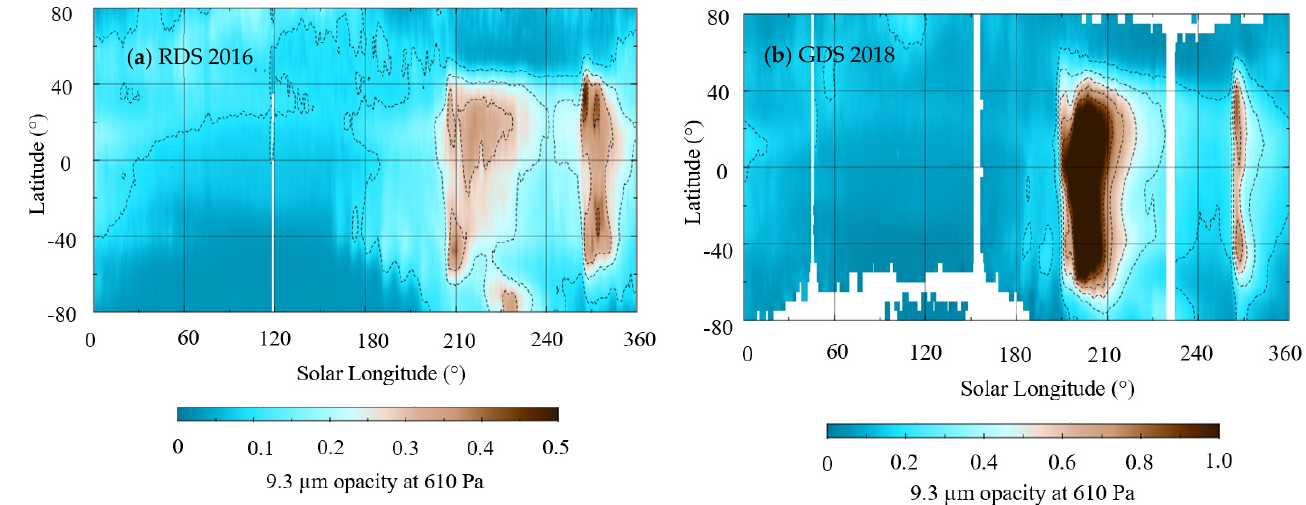
Figure 1. Distribution of dust versus latitude and solar longitude as measured using the 9.3-µm vertical column opacity normalized to 610 Pa during ( a ) RDS 2016 and ( b ) GDS 2018. Gridded infrared absorption retrievals of the column dust optical depth (CDOD) by the Mars Climate Sounder (MCS) aboard the Mars Reconnaissance Orbiter Spacecraft [32] were used to produce the plot. Data are available at [33].